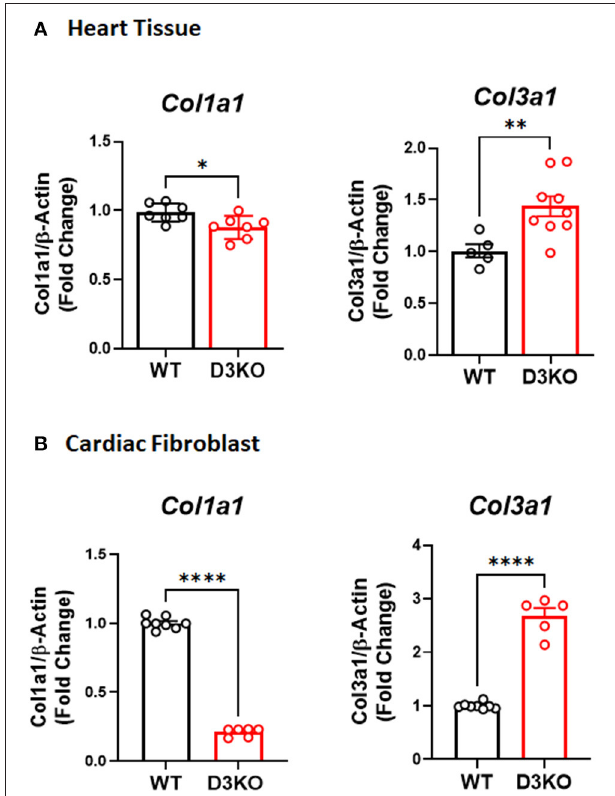
FIGURE 4 | Collagen Gene Expression in WT and D3KO Cardiac Tissue and Fibroblast Cells: (A) Gene expression determined using TaqMan primers by real-time qPCR ( n = 3, run in duplicates); Gene expression data for Col1a1 and Col3a1 was derived from WT and D3KO whole heart tissues. All values are Fold Change normalized to WT. There is a significant decrease in Col1a1 gene expression in D3KO heart tissue compared to WT and a significant increase in Col3a1 gene expression in D3KO heart tissue compared to WT. * p < 0.05, ** p < 0.01, statistically significant; Bars represent standard error of mean. (B) Gene expression determined using TaqMan primers by real-time qPCR ( n = 4, run in duplicates); Gene expression data for Col1a1 and Col3a1 was derived from WT and D3KO LV cardiac fibroblasts. All values are Fold Change normalized to WT, **** p < 0.0001 statistically significant, bars represent standard error of